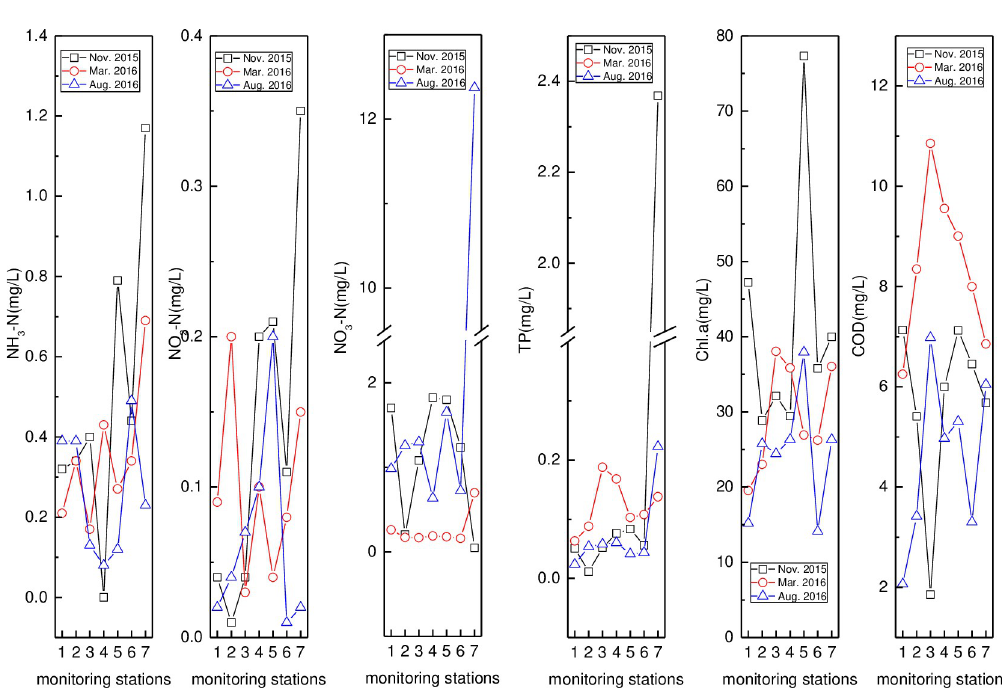
Fig 5. Variation of pH, T, EC, DO, and ORP in Wenchang River (monitoring stations including HN07, HN06, HN05, HN04, HN02, and HN01 are represented by 1–6).